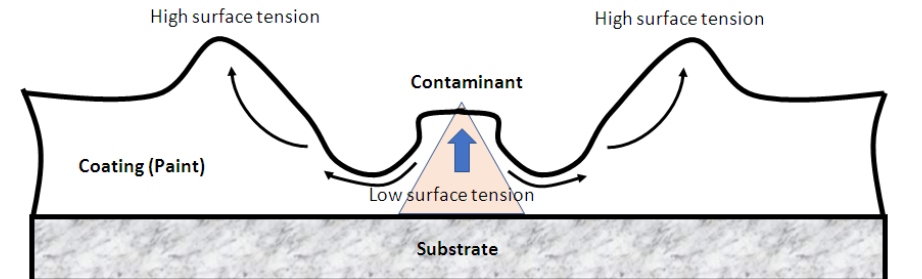
Figure 3. Contamination defect called as fish-eye defect. Table 2. The tests and the